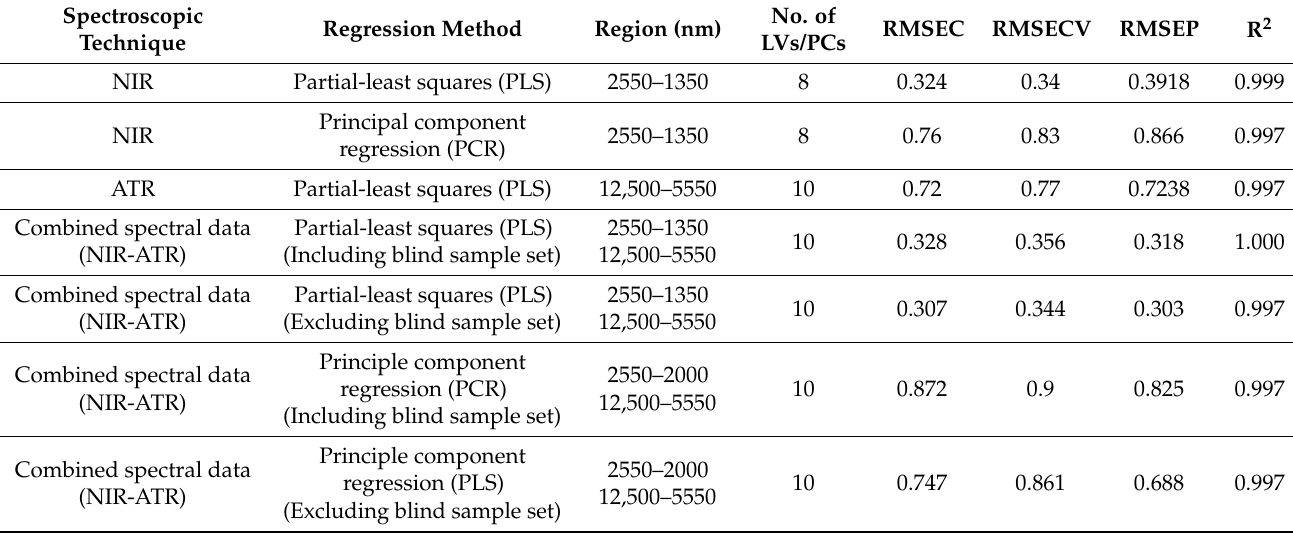
Table 1. Summary of regression